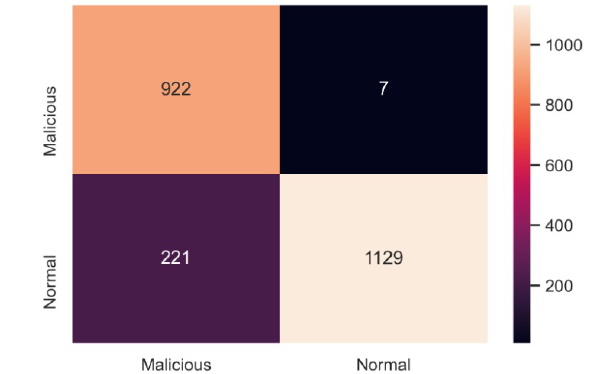
Figure 13. Confusion matrix for XSS and SQL injection detection model tested.